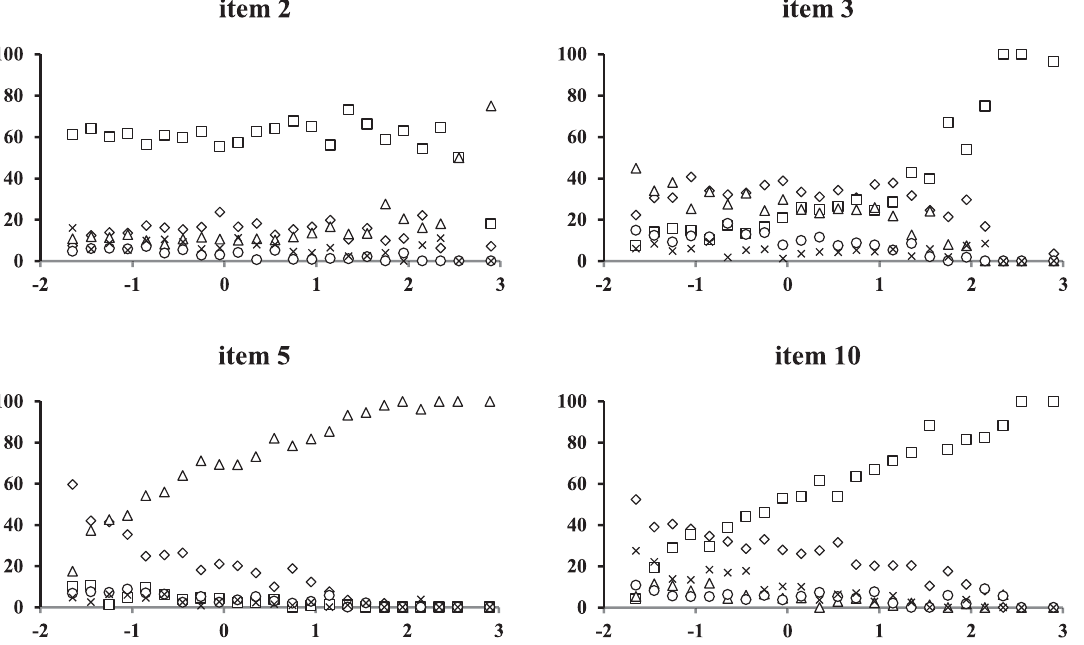
FIG. 6. IRCs for items 2, 3, 5, and 10, representing the fractions of respondents at any given ability that chose option ⋄ ¼ A, □ ¼ B, Δ ¼ C, o ¼ D, or × ¼